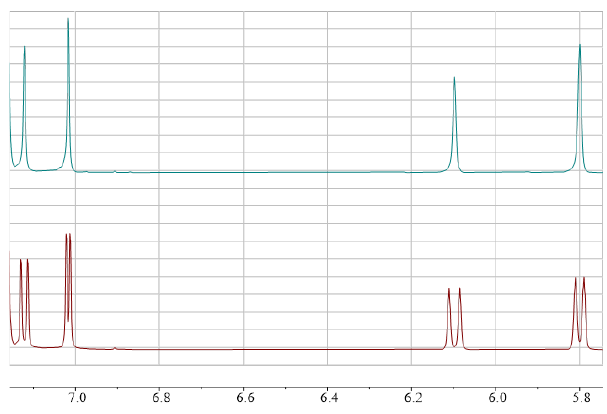
Figure1. The600MHz 1 H-NMRspectrumof 2a inCDCl 3 (red—spectrawithoutdecoupling, cyan—with Figure 1. The 600 MHz 1 H-NMR spectrum of 2a in CDCl 3 (red – spectra without decoupling, cyan – 19 F decoupled irradiated 19 F atoms ( 1 H-{ 19 with 19 F decoupled irradiated 19 F atoms ( 1 H-{ 19 F}).